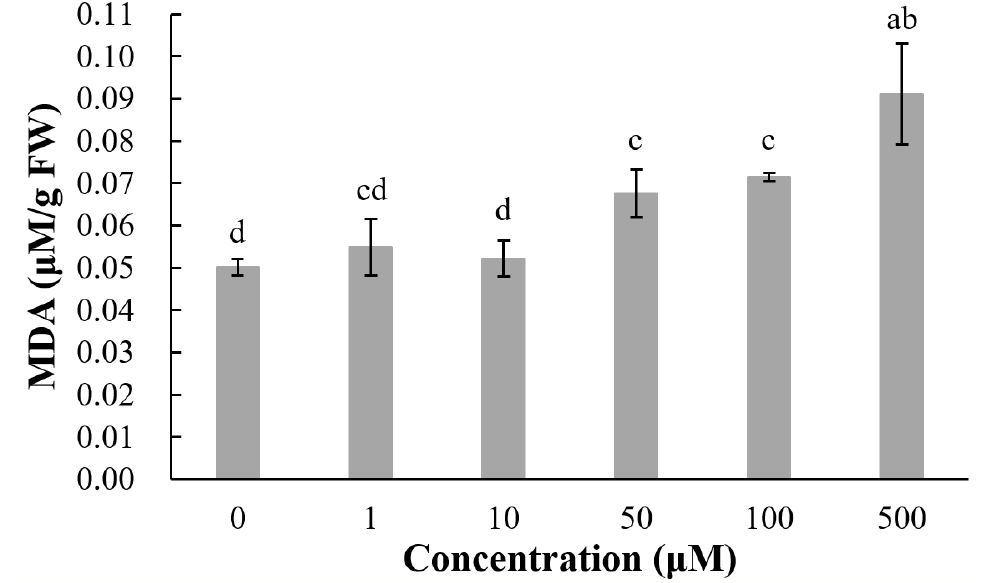
Figure 8. MDA content in roots of lettuce seedlings after treatments with acacetin. The results presented are mean of three replicates ± SE, different letters denote significant differences at p < 0.05 according to one-way ANOVA with an LSD test.